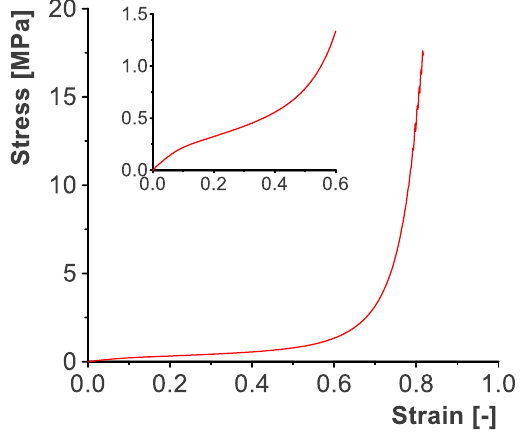
Figure A1. Compression force deflection curve of the compression pad PORON ® 4701-60 Polyurethane used to measure the pressure distribution.